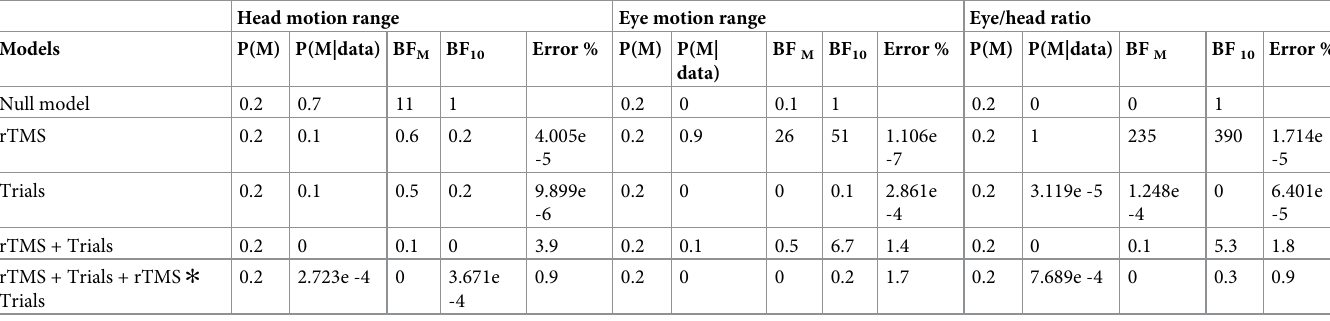
Table 3. Bayesian two-way ANOVA (model comparison) in % change.